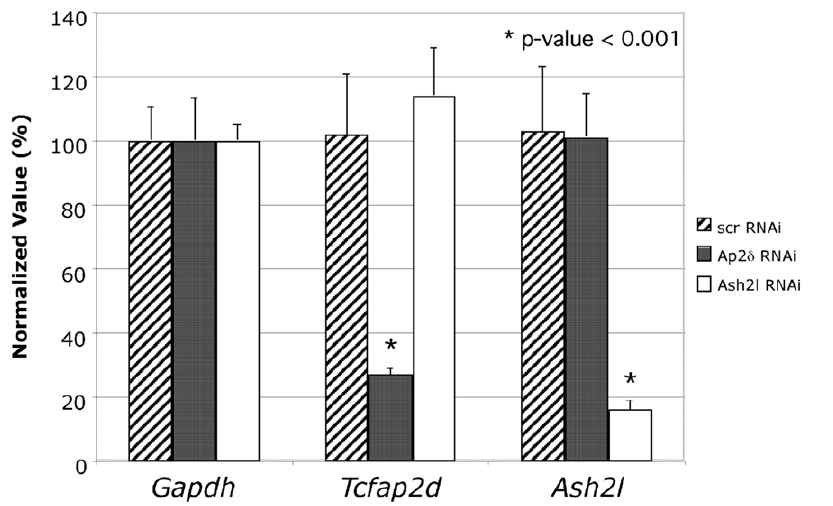
Figure 1. Tcfap2d and Ash2l are downregulated in Neuro2a cells treated with either Ap2 d or Ash2l RNAi. Total RNA was extracted 72 hours post-transfection from Neuro2a cells treated with Tcfap2d - or Ash2l -specific siRNA or scrambled control. Gapdh , Tcfap2d and Ash2l transcript levels were quantified by real-time PCR. Normalized values were calculated as percentages of transcript levels detected in cells treated with the scrambled control. Significant differences are as indicated with * (p # .001).